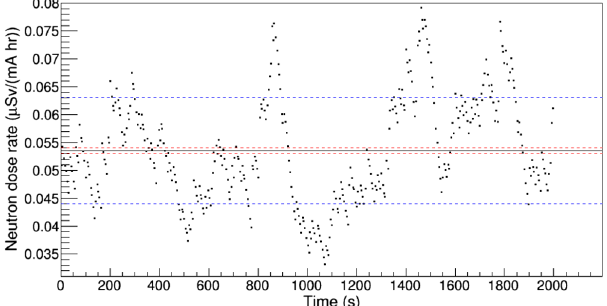
FIG. 2. Example of the data analysis for the measurements collected with the WENDI-2 dosimeter. The solid line represents the average of the data, the outer dashed lines represent the standard deviation and the inner dashed lines represent the standard deviation of the